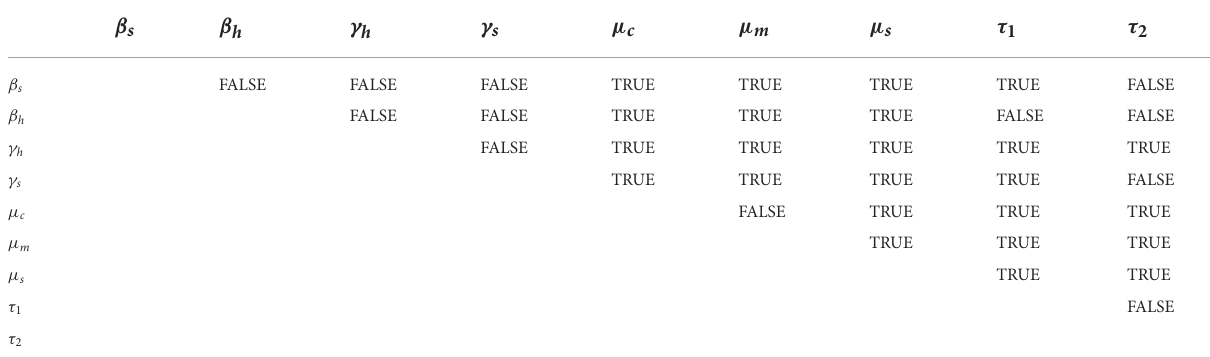
TABLE 6 Parameters different after FDR